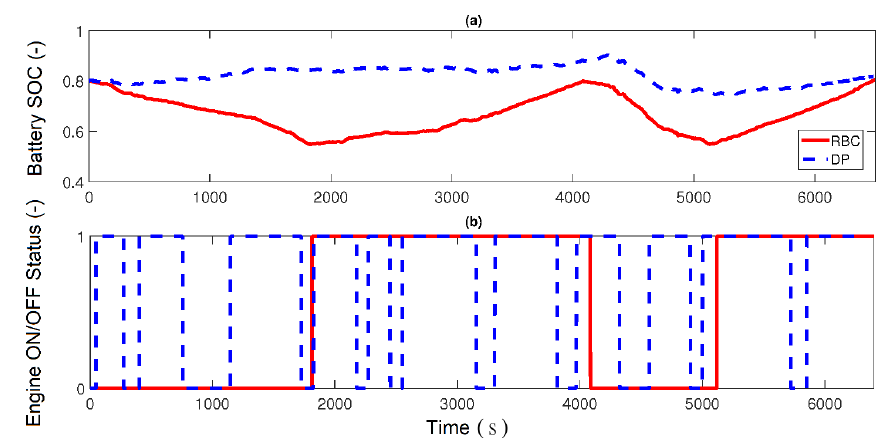
Figure 12. Engine on/off status and the battery SOC pattern in the 3-mode DP and RBC strategies. ( a ) Engine on/off status and ( b ) the battery SOC pattern in the 3-mode DP and RBC strategies.